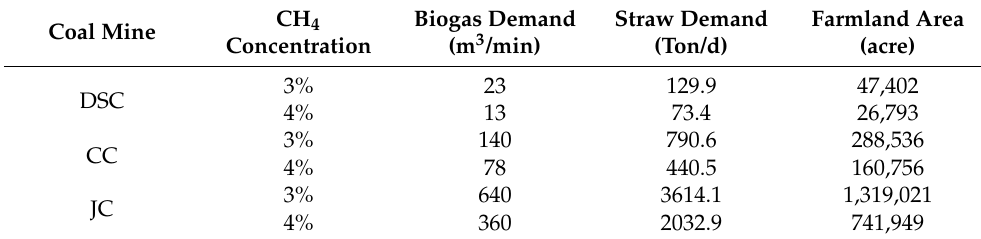
Table 3. Parameters of the co-production system for power generation in coal mines.